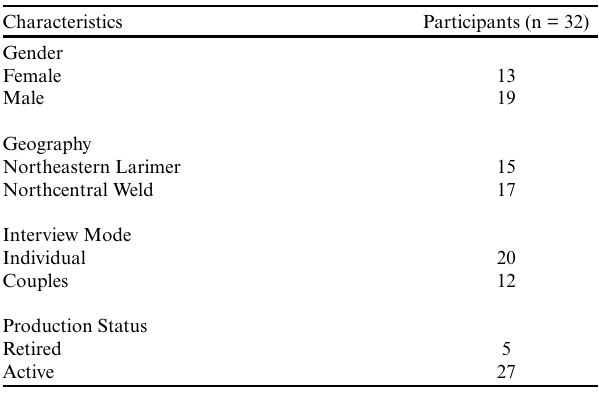
Table 1 . Characteristics of interview